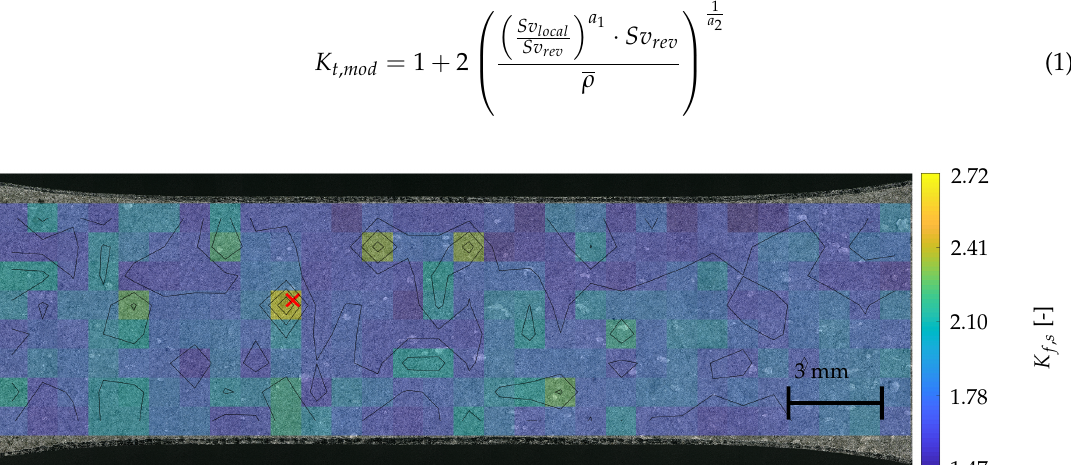
Figure 1. Exemplarily mapping of the surface fatigue notch factor K f , s with 1 mm × 1 mm